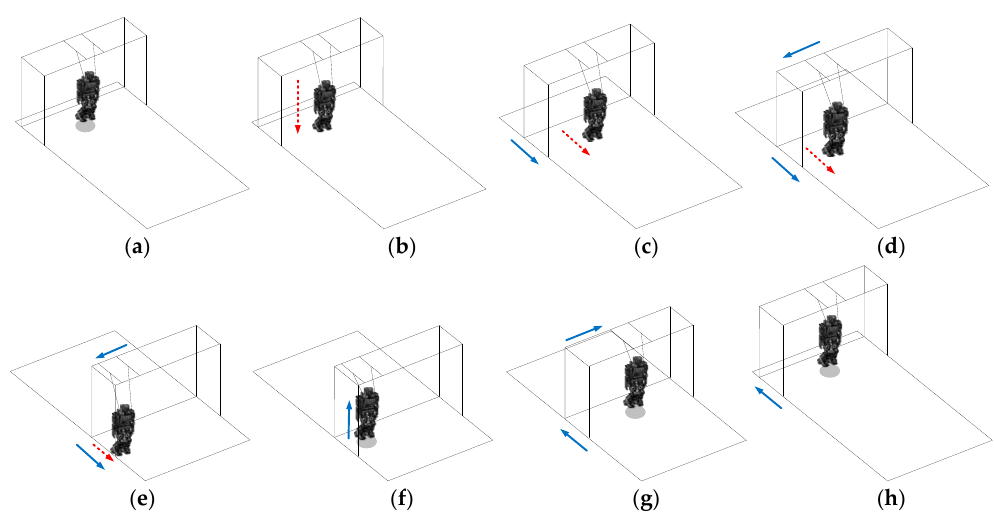
Figure 9. Process of the automatic training platform: ( a ) robot is suspended in the start state; ( b ) robot is put on the training field in the start state; ( c ) platform moves forward to follow the robot in the operation state; ( d ) platform moves forward and right to follow the robot in the operation state; ( e ) robot is in a danger region and is followed by the platform in the end state; ( f ) robot is pulled up by the platform in the end state; ( g ) platform goes back in the return state; ( h ) platform goes back to the initial position in the return state.